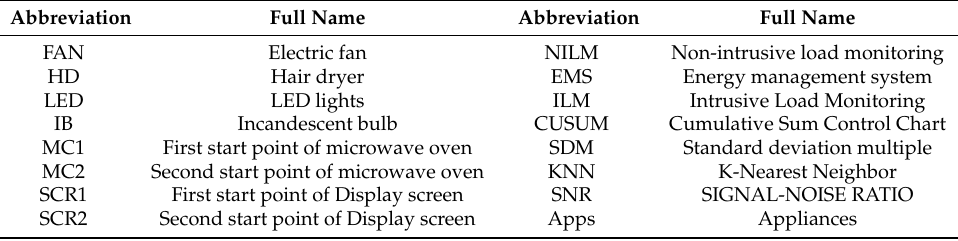
Table A1. Abbreviations and full names in this